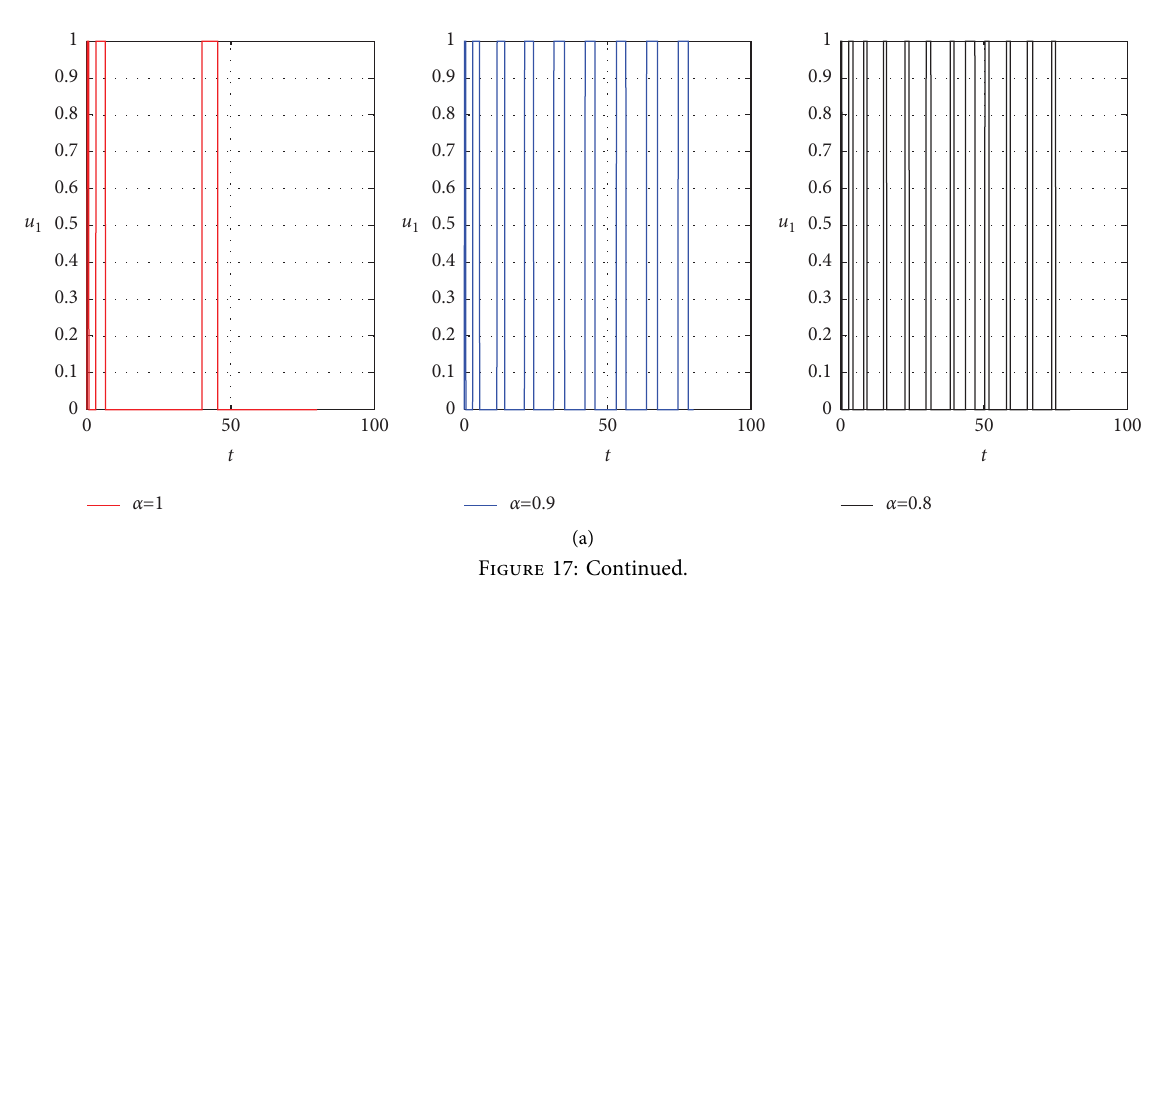
Figure 16: Dynamics of z ( t ) where a � 0 . 1 , b � 0 . 1 , c � 0 . 1 , e � 0 . 3 , f � 0 . 2 , h � 0 . 3 , i � 0 . 2 , C � 0 . 01 , A � 0 . 02 , andA A 1 2